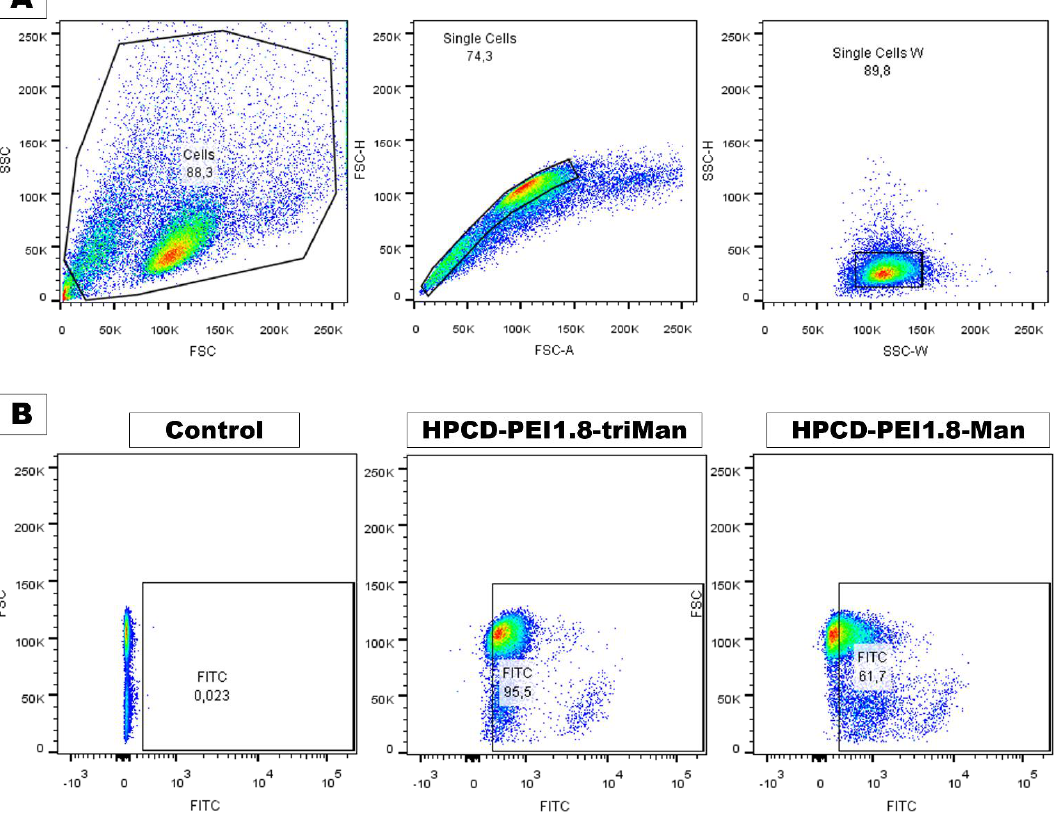
Figure 10. Flow cytometry of macrophage-like cells. ( A ) Gating strategy. Selection of single cells by forward-scattered (single cells) and side-scattered light (single cells W). ( B ) Flow cytometry data on FITC macrophage-fluorescence distribution for cells preincubated with HPCD-PEI1.8-triMan or HPCD-PEI1.8-Man and control cells.